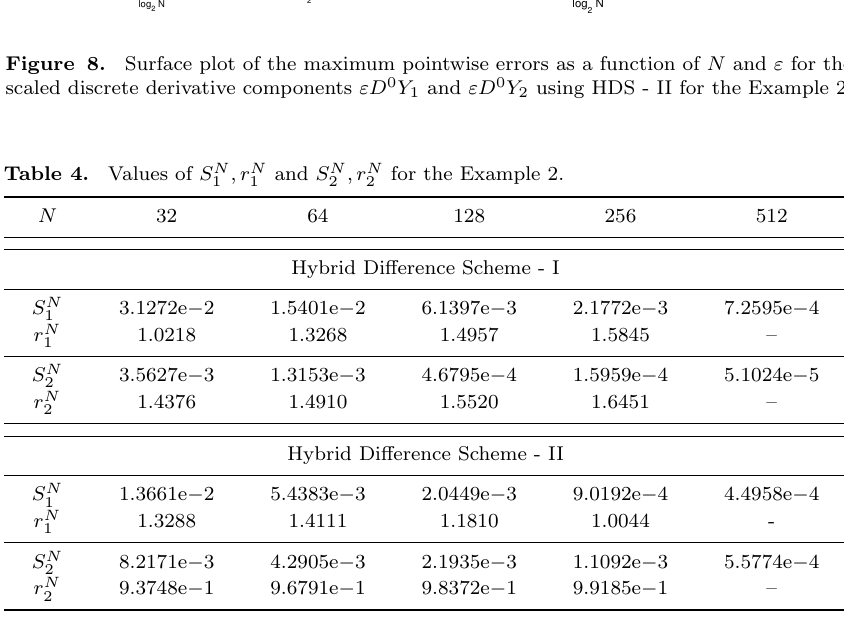
Table 4. Values of S N